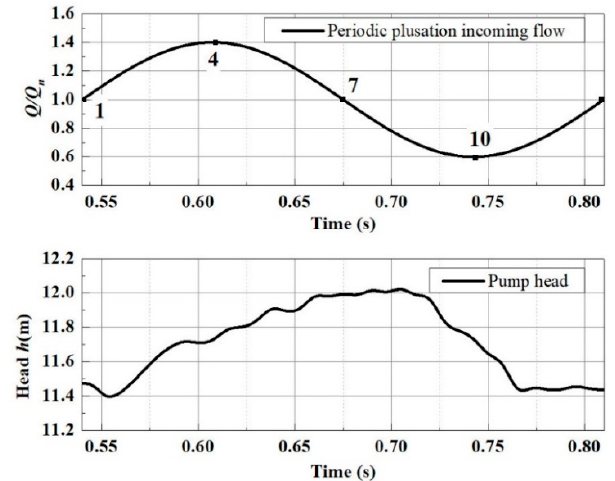
Figure 6. Phase analysis of the pump head versus the periodic incoming pulsation flow.